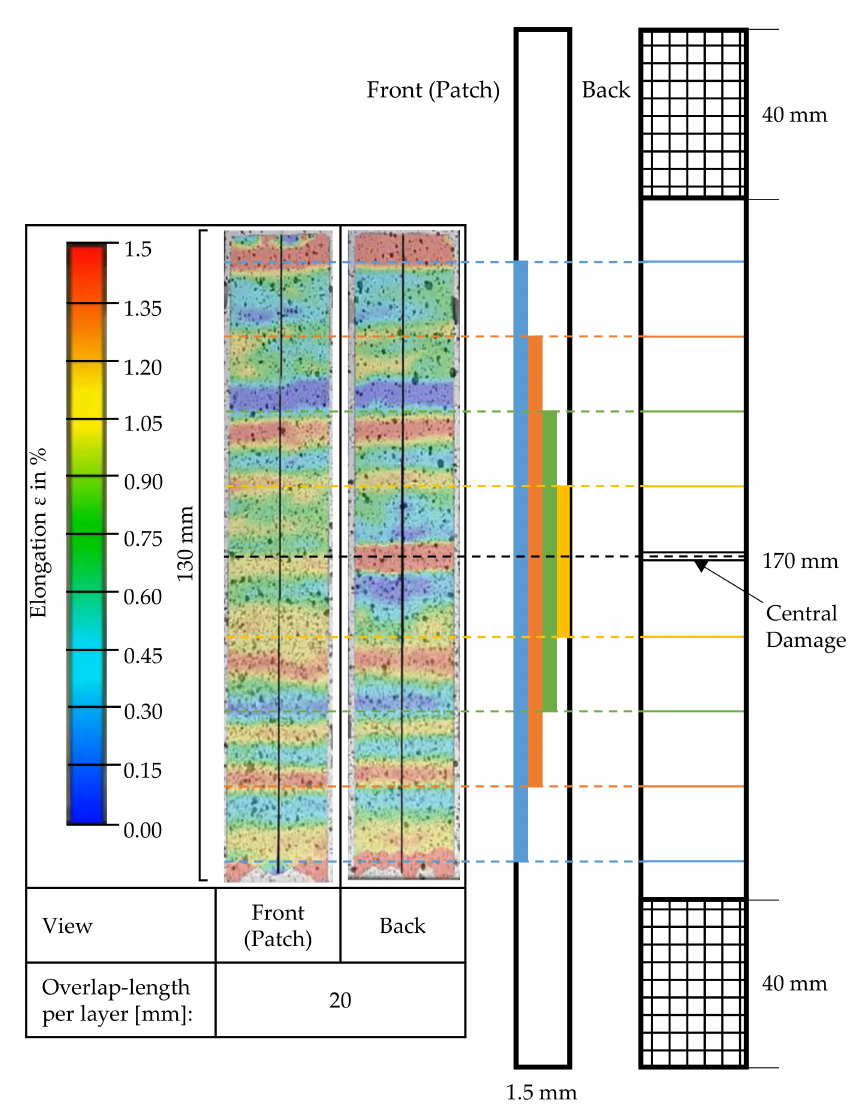
Figure 9. Results of the DIC during tensile testing just before the breakage of damaged samples ‘patch-repair’ with UD